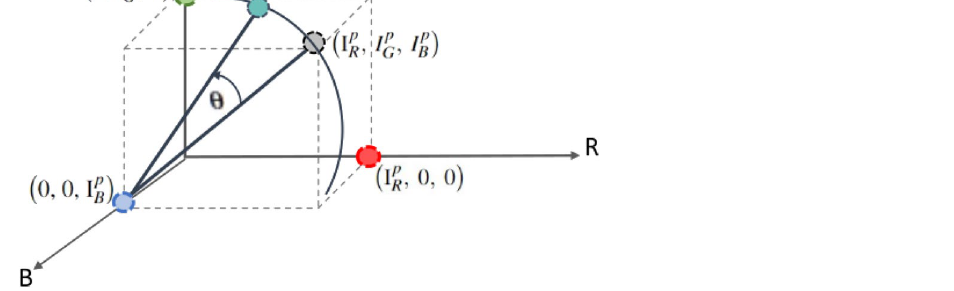
Figure 4. Pixel undergoing 3D